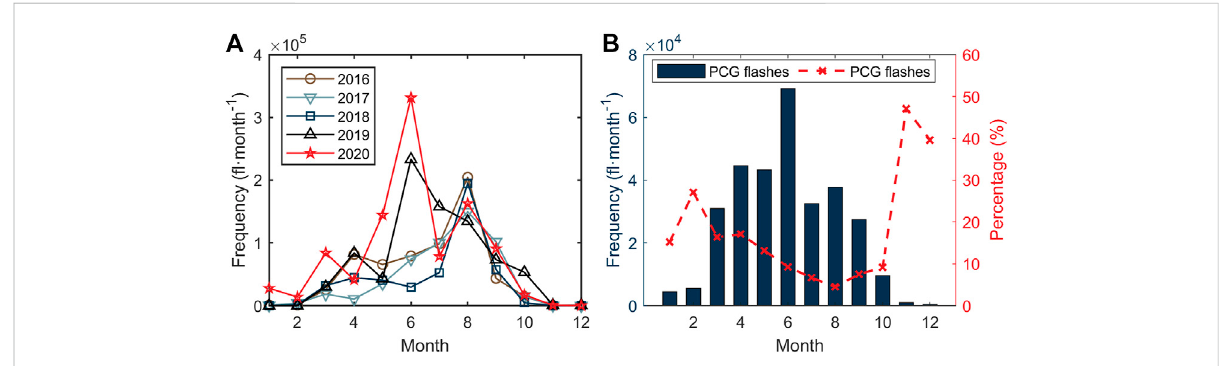
FIGURE 7 (A) The monthly distributionof the lightning frequency on the Yungui Plateaufrom 2016 to 2020. (B) The monthly distribution of thefrequency and percentage of PCG lightning